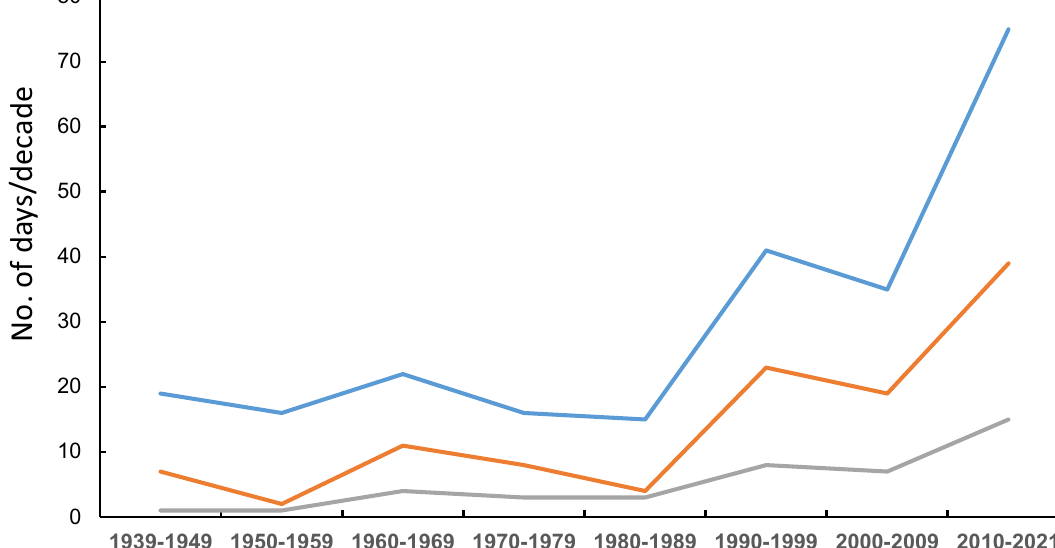
Figure 8. Climate change in Rockhampton from1939-2021. The historical record maximum temperature from Rockhampton weather station (23.38oS, 150.51oE), was downloaded which included data from 1939–2021 from bom.gov.au. The number of days per decade over 38 °C (blue),39 °C (orange)and 40 °C (grey) are